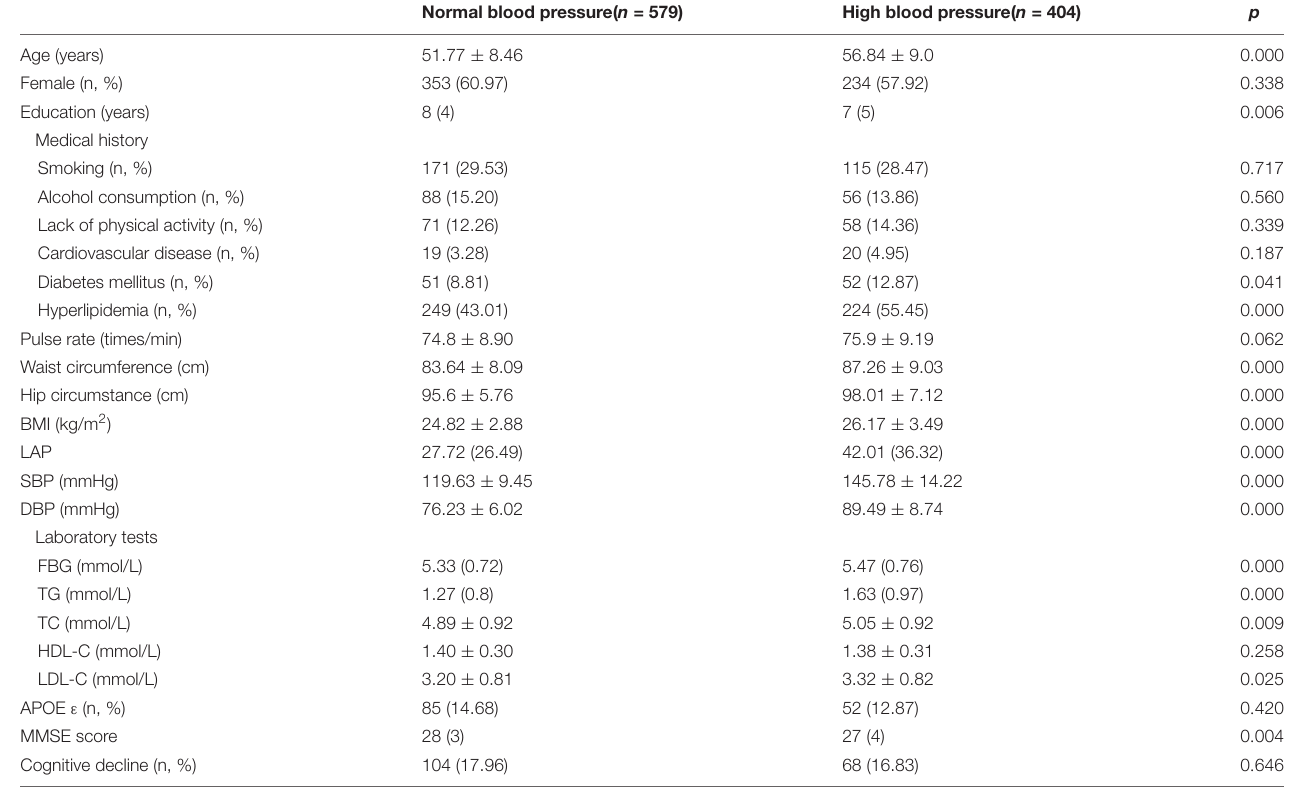
TABLE 5 | Comparison of Normal blood pressure group and High blood pressure group in total study population. Normal blood pressure( n =